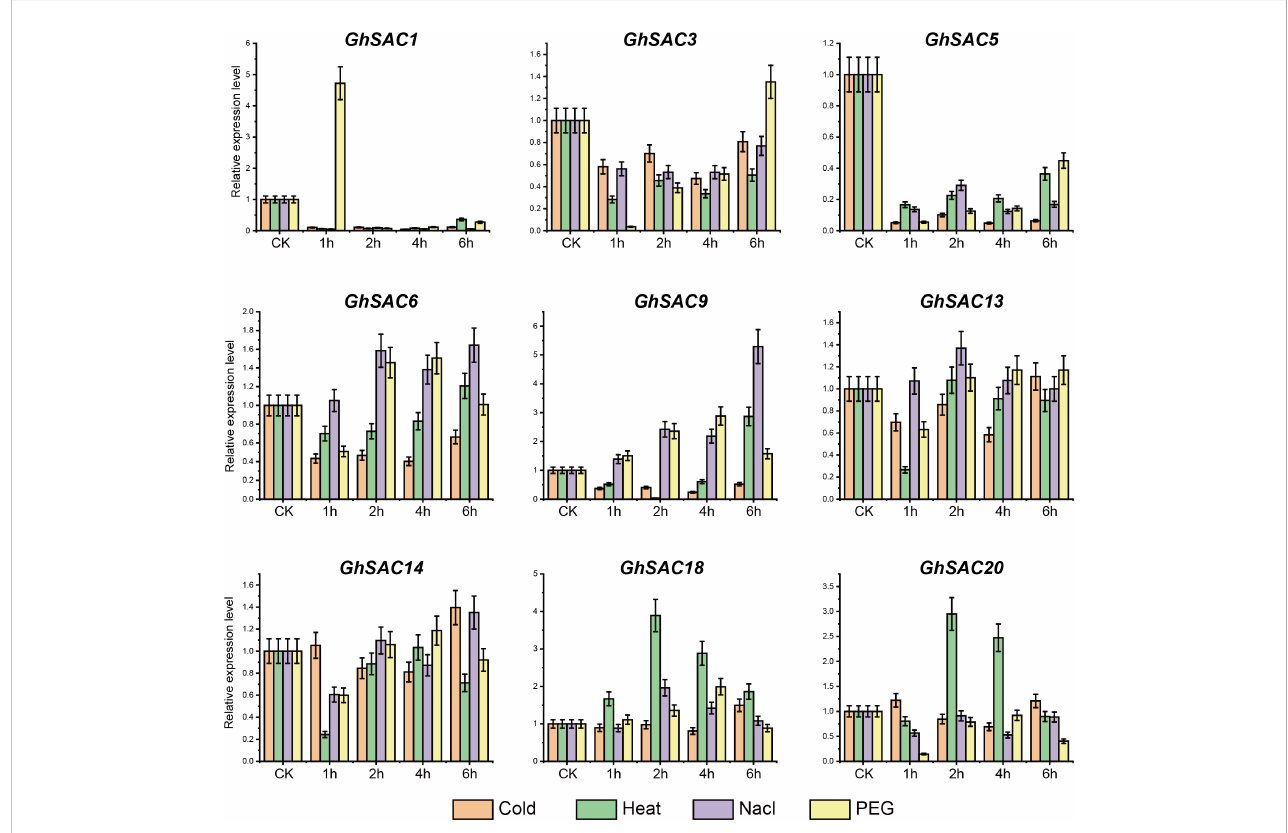
FIGURE 6 Responses of GhSAC genes under abiotic stresses. qRT-PCR analysis was performed to observe the relative expression patterns of GhSAC genes under cold, heat, NaCl, and PEG treatment. Each experiment was conducted in three biological repeats and the error bar represents the standard deviation among